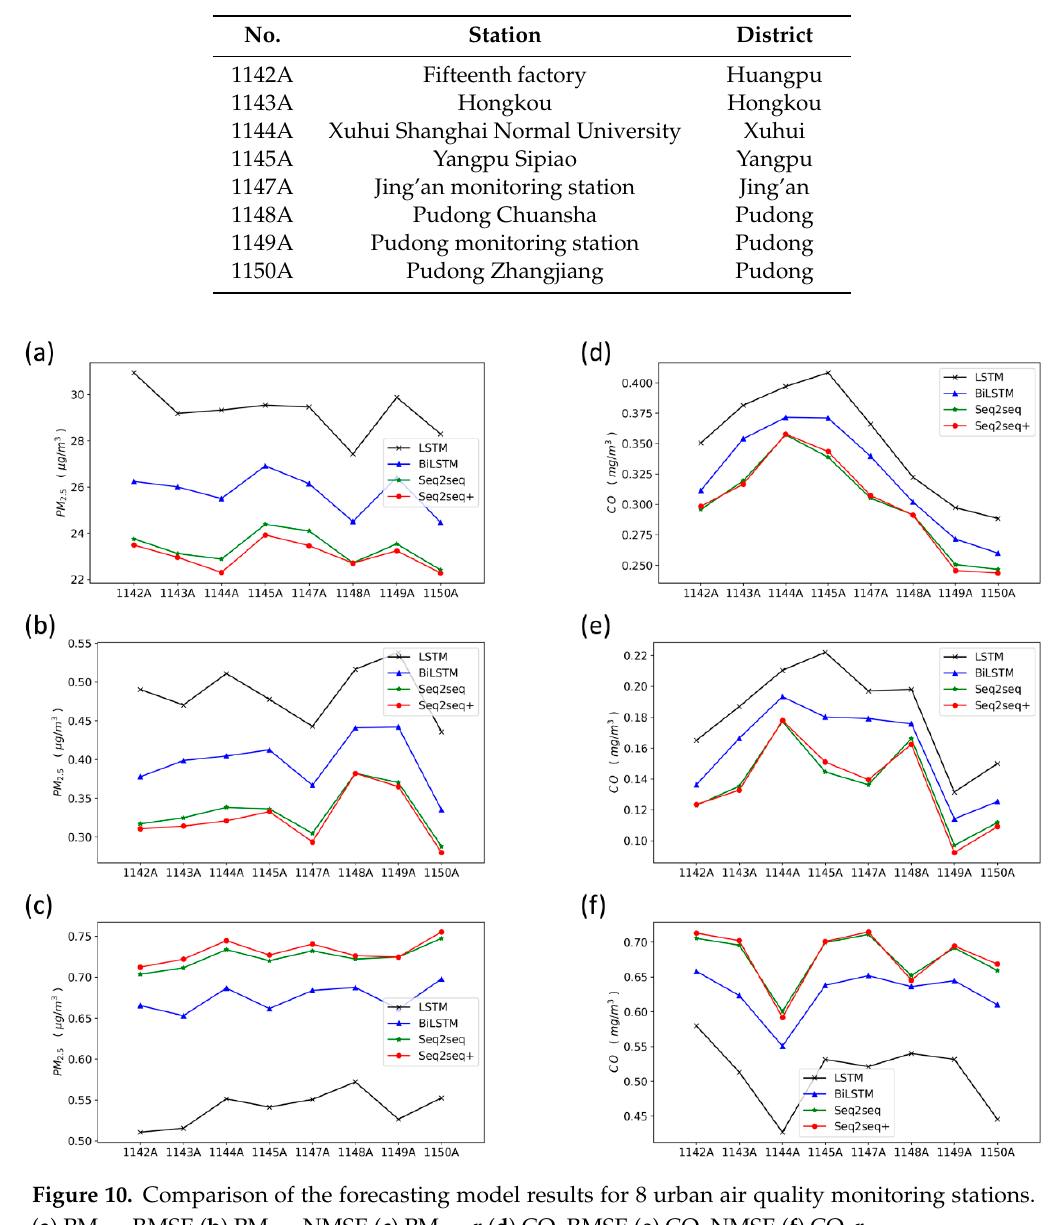
Table 3. Description of urban air quality monitoring stations.